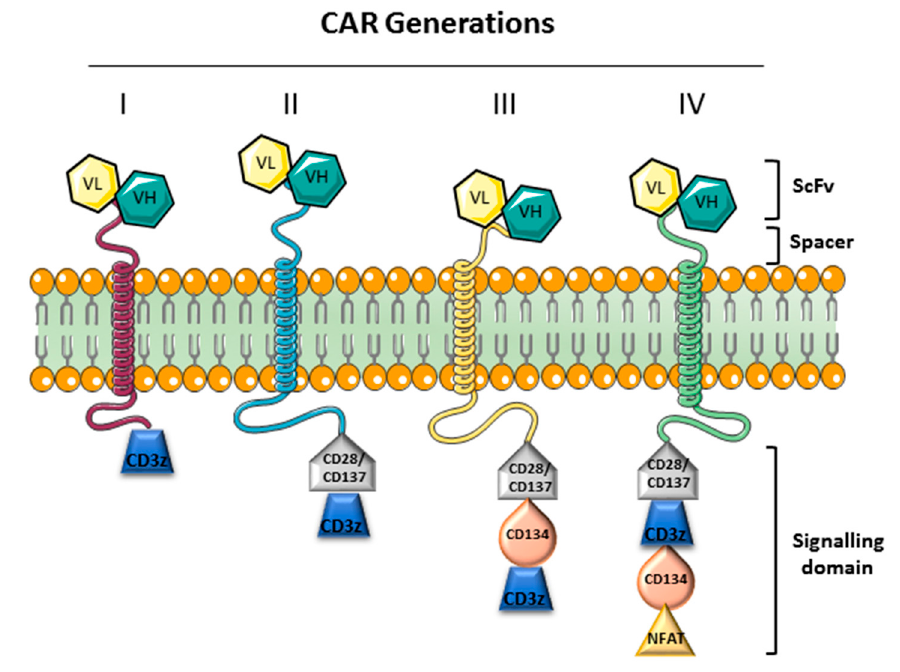
Figure 3. Schematic representation of CAR generation molecules.